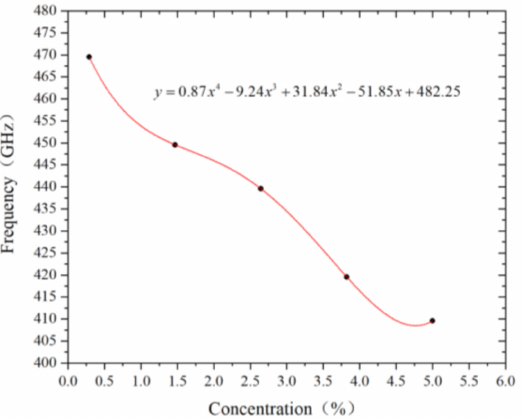
Figure 8. Graphene resonant frequency variation polynomial fitting curve with vacancy